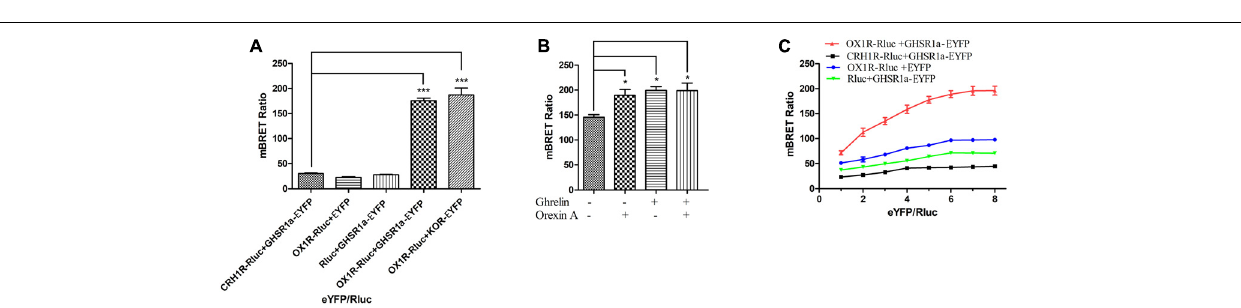
FIGURE 2 | Heterodimerization of GHSR1a/OX1R examined with BRET assay in live cells. Heterodimerization of GHSR1a/OX1R was measured by BRET. HEK293 cells were transiently transfected with the donor plasmids and acceptor plasmids. Twenty-four hours after transfection, both the fluorescence and luminescence of each sample were measured prior to every experiment to confirm equal expression of Rluc while monitoring the increase in Venus expression. (A) BRET ratios were analyzed and are expressed as the means ± SEM ( N = 3) of four experiments. ∗∗∗ p < 0.001, OX1R-Rluc+ GHSR1a-EYFP vs. control groups (CRH1R-Rluc/GHSR1a-EYFP), as a positive control group (OX1R–Rluc/ κ OR-EYFP). (B) Effects of ghrelin and/or orexin-A on the BRET ratio. HEK293 cells were co-transfected with OX1R-Rluc and GHSR1a-EYFP plasmids (1:3). After 24 h of transfection, the Rluc substrate Coelenterazine h was added for 5 min, and the cells were treated with ghrelin (100 nM) and/or orexin-A (100 nM) or vehicle for 10 min, BRET ratios were analyzed and are expressed as the mean ± SEM of four experiments. ∗ p < 0.05 compared with the control group (no treated). (C) BRET saturation assay. HEK293 cells were co-transfected with a constant amount of the OX1R-Rluc construct, each at 0.15 µ g/well, and increasing amounts of the EYFP construct (0.15–1.2 µ g/well). Calculated BRET ratios were plotted relative to total fluorescence/luminescence ratios, and the data were analyzed by non-linear regression curve fitting (one site–specific binding) using GraphPad Prism software. BRET ratios were analyzed and are expressed as means ± SEM ( N = 3) of four